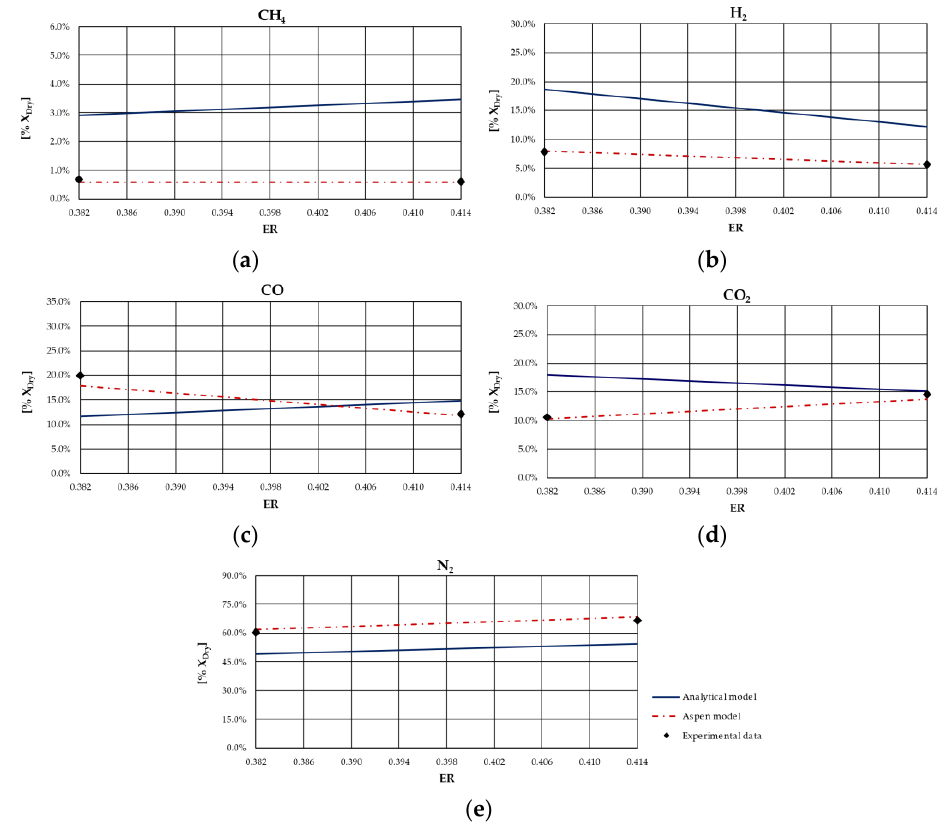
Figure 7. Comparison of syngas mole fraction composition between the results of calibrated and non-calibrated analytical and Aspen models and experimental data from rice husk gasification [36]: ( a ) CH 4 mole fraction; ( b ) H 2 mole fraction; ( c ) CO mole fraction; ( d ) CO 2 mole fraction; ( e ) N 2 mole fraction.